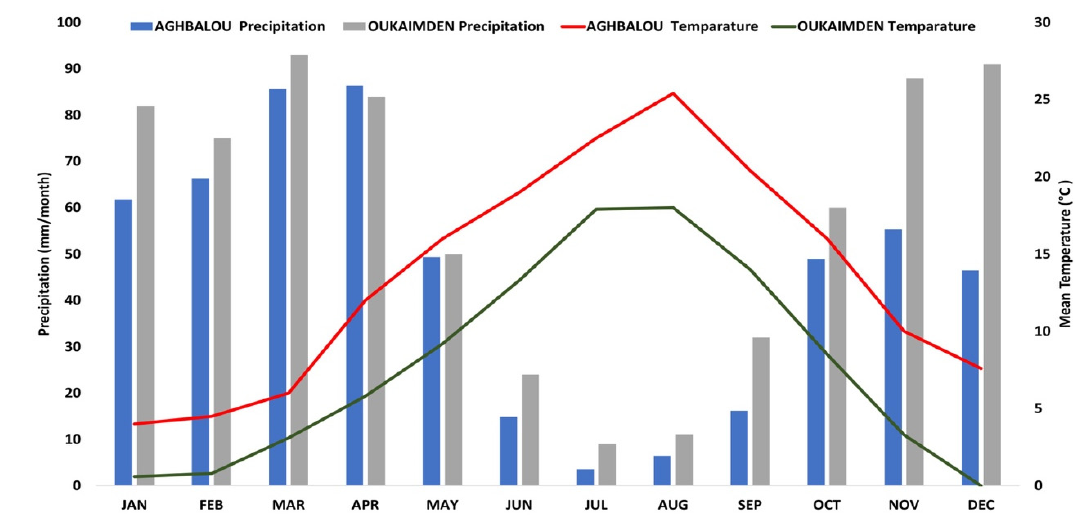
Figure 2. Monthly mean temperature and precipitation at weather stations for the period of (1970–2014) in Ourika watershed.